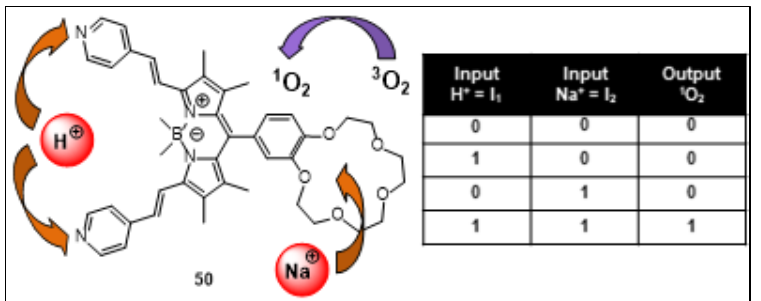
Figure 48 . AND logic gate 50 with two inputs (H + and Na + ) and singlet oxygen as output [152].